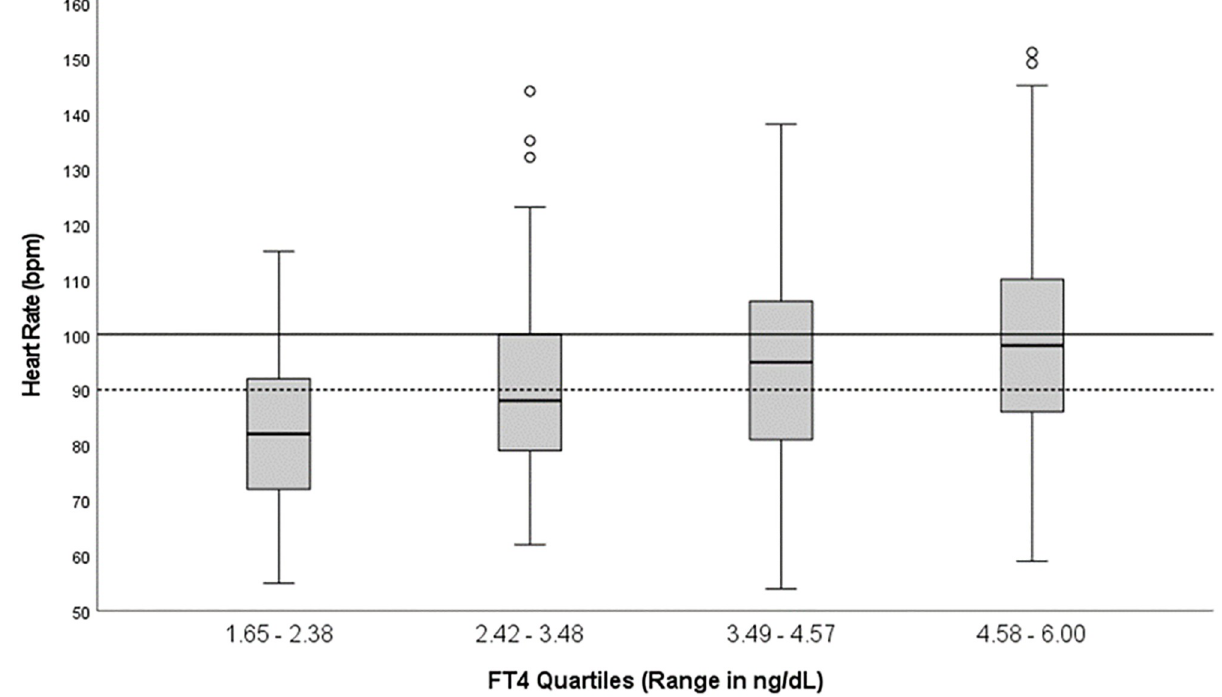
Fig 2. Median heart rate and IQR in four fT4 quartiles: Solid line represents tachycardia (HR > 100 bpm), whereas broken line denotes HR > 90 bpm.